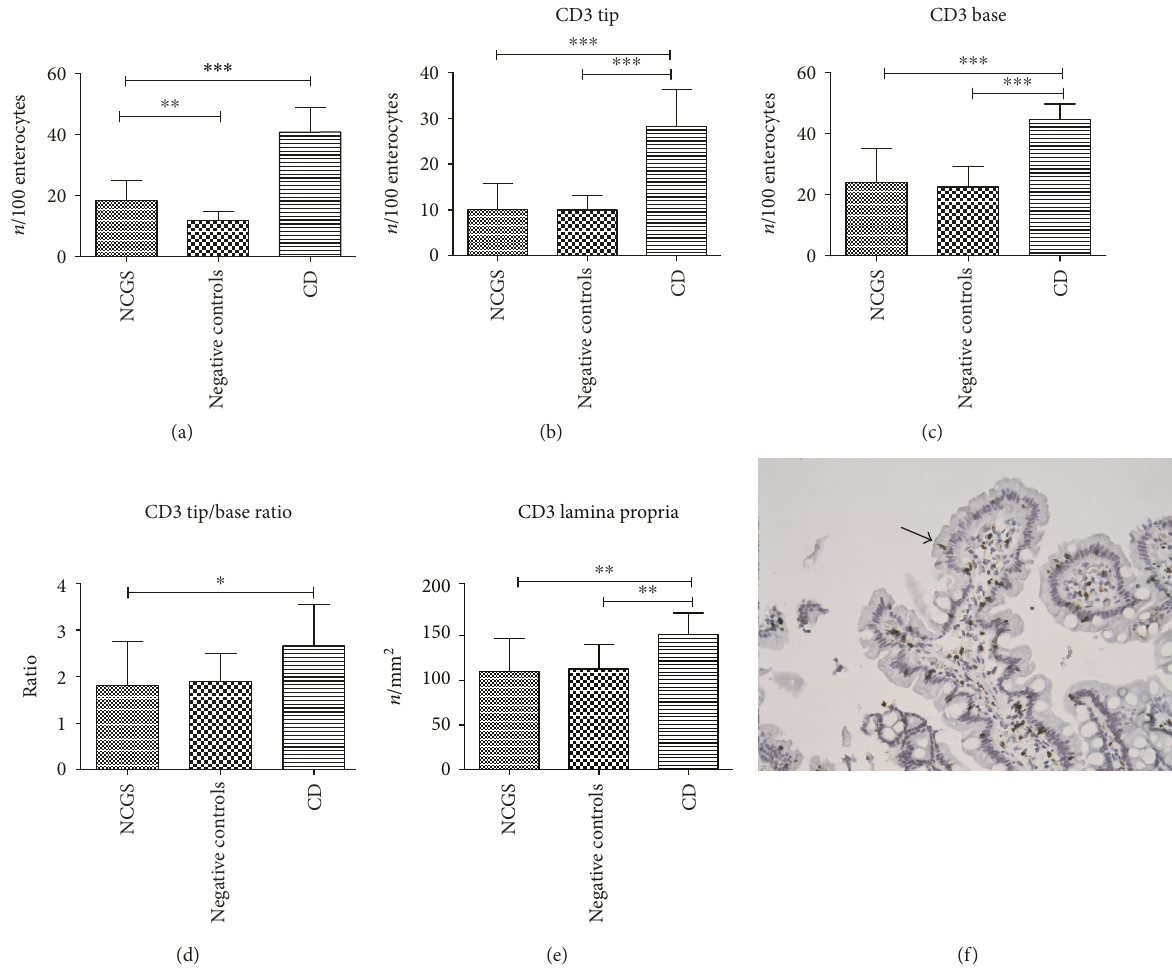
Figure 1: Immunohistochemical expression of CD3 in duodenal mucosa, both epithelial and lamina propria (a – e). Bars and error bars represent mean and standard deviation, respectively. ∗ p < 0 05 , ∗∗ p < 0 01 , and ∗∗∗ p < 0 001 . (f) An immunohistochemical picture of a patient with NCGS: positive cells are stained in brown, magni fi cation × 200. An arrow highlights positive